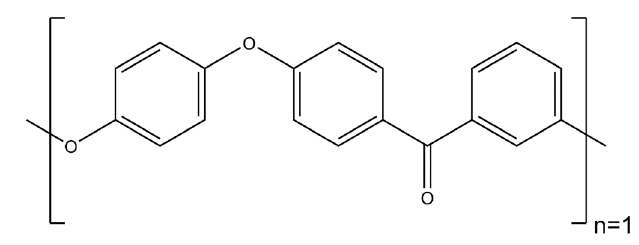
Figure 7. Molecular structure of peek monomer.